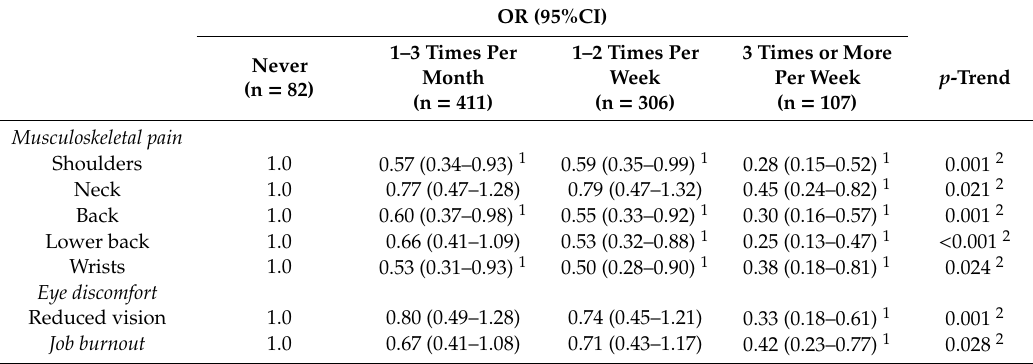
Table 5. Age-, gender-, and VDT time out of work-adjusted odds ratios (OR) and 95% confidence intervals (95% CI) of exercise frequency for selected health